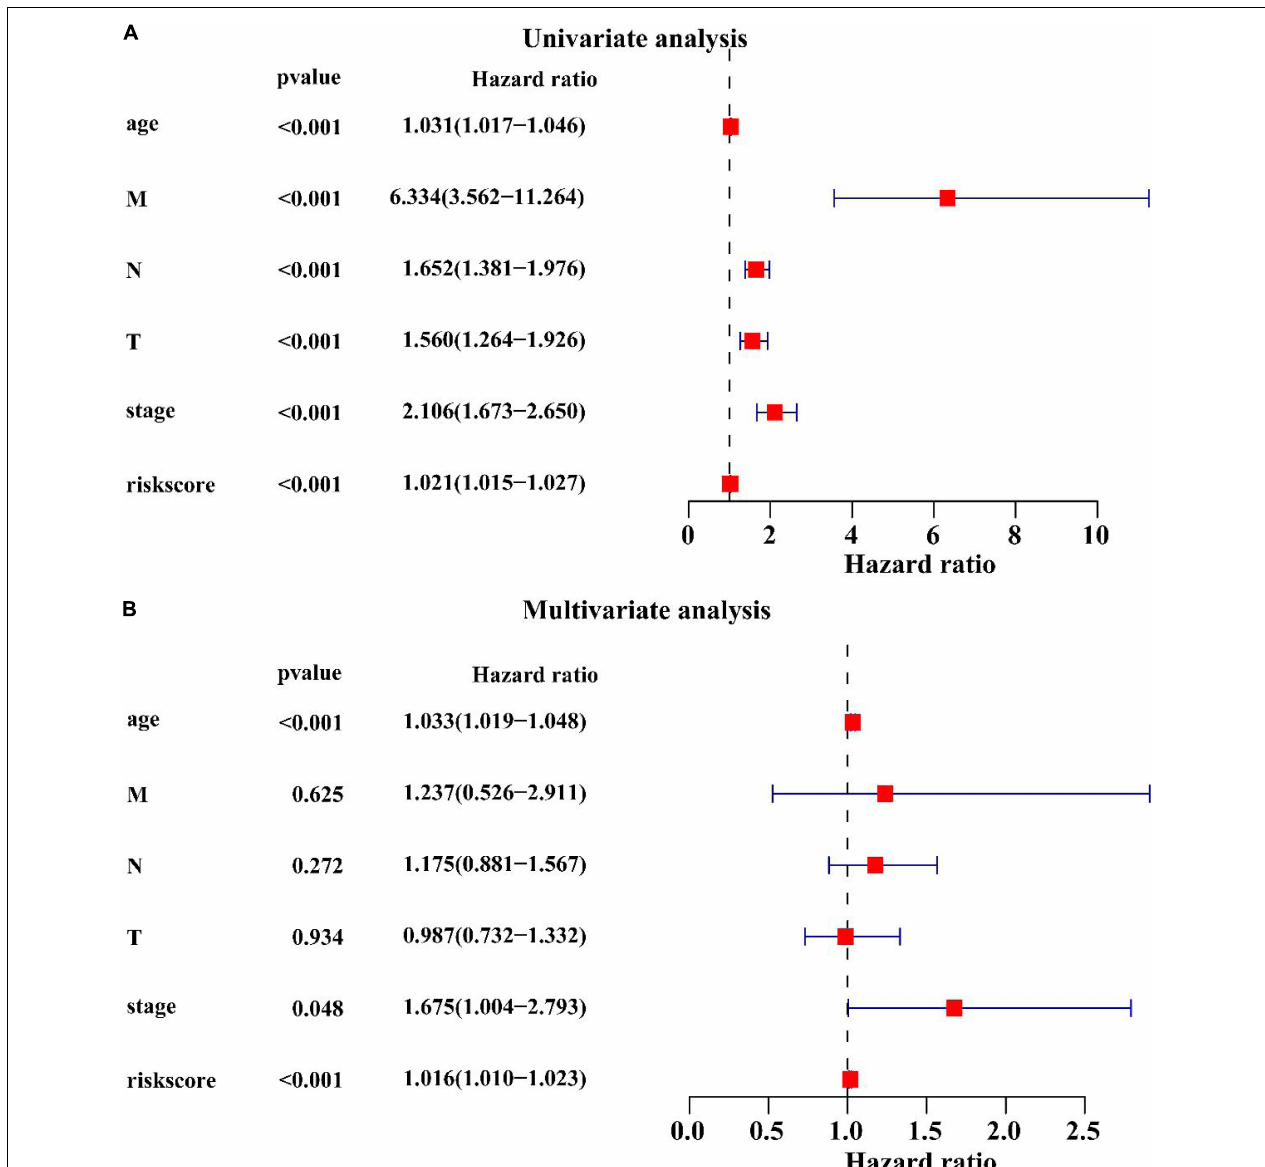
FIGURE 8 | Univariate and multivariate Cox regression analysis of clinicopathological factors related to the BC prognosis. (A) The univariate forest plot illustrated the clinicopathological factors related to the BC prognosis. (B) The multivariate forest plot exhibited the clinicopathological factors related to the BC prognosis.